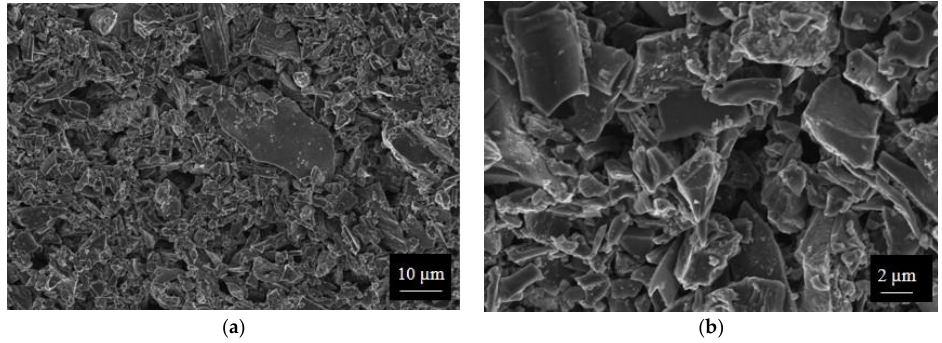
Figure 6. Field Emission-Scanning Electron Microscopy (FESEM) micrographs of OSR700 biochar sensor at different magnifications: ( a ) 2500×; ( b ) 10,000×.